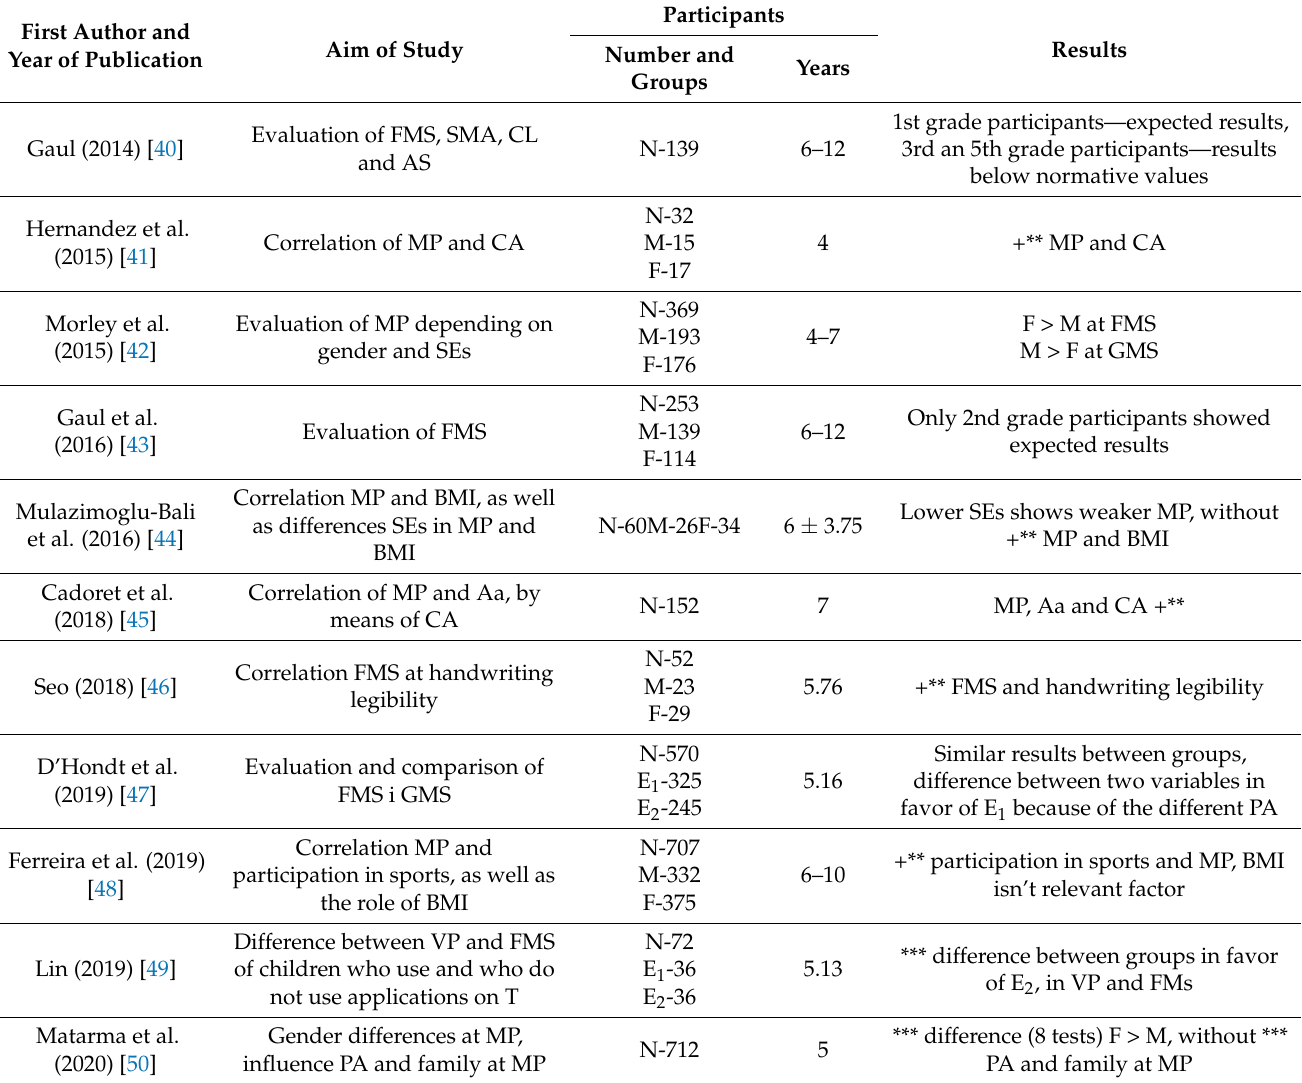
Table 3. Cross-sectional studies of short form BOT-2